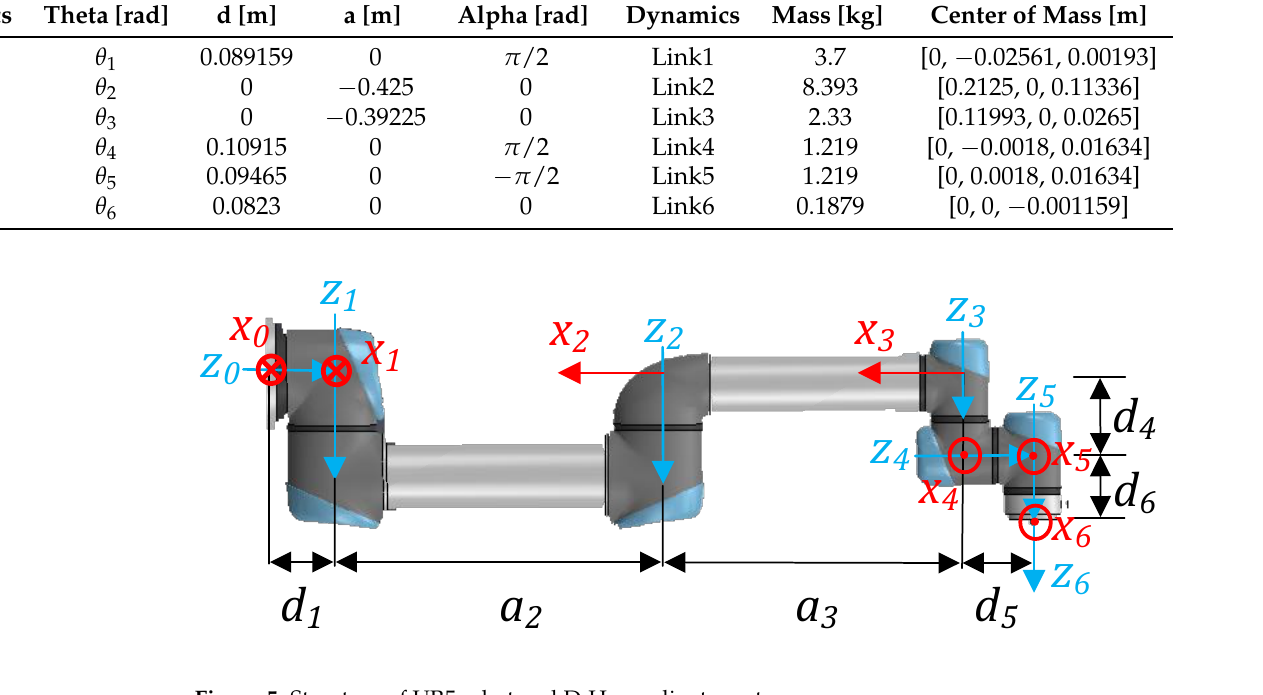
Figure 5. Structure of UR5 robot and D-H coordinate system.